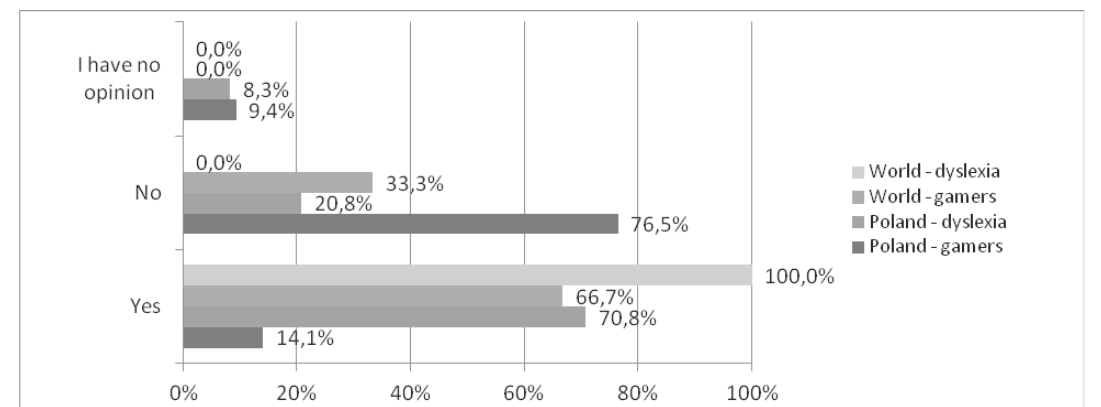
Figure 4. (cid:47)(cid:72)(cid:68)(cid:85)(cid:81)(cid:76)(cid:81)(cid:74)(cid:3)(cid:83)(cid:85)(cid:82)(cid:69)(cid:79)(cid:72)(cid:80)(cid:86)